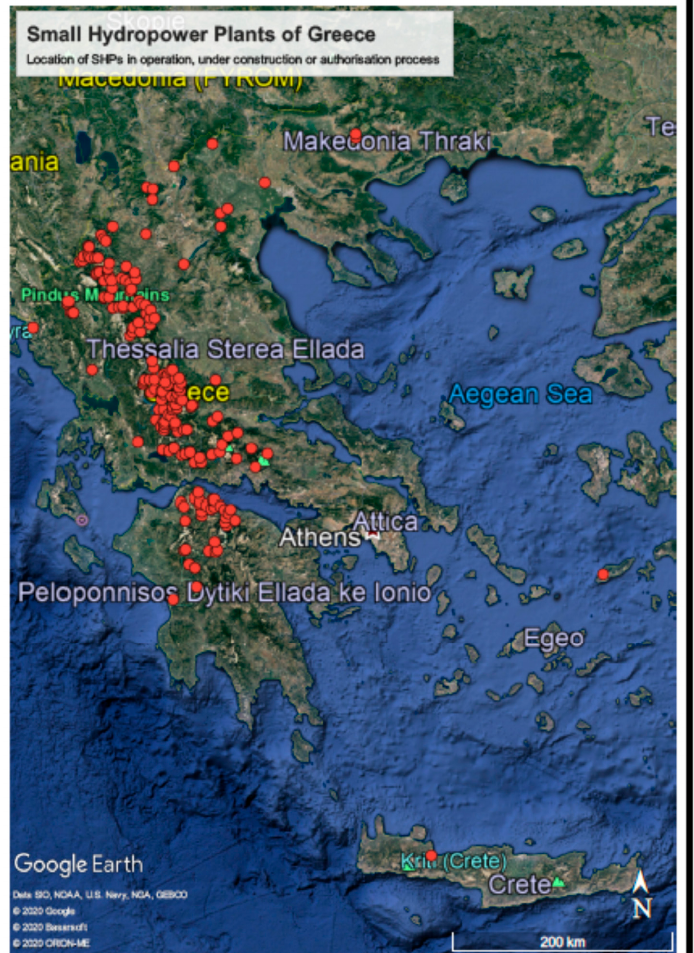
Figure 2. Location of the small hydropower plants in Greece (in operation, in planning or in process of license authorization).